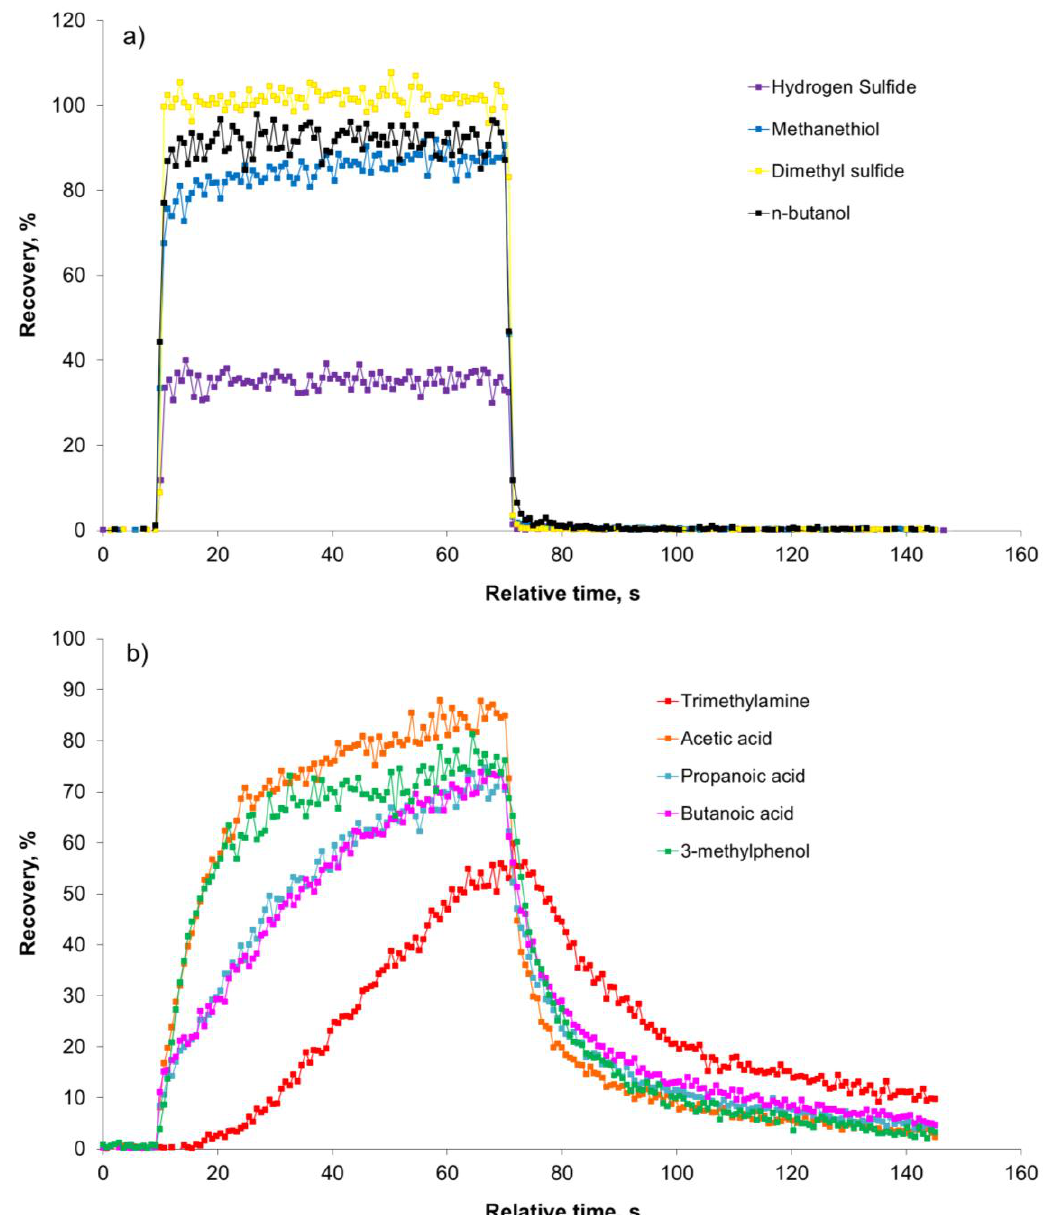
Figure 3. Development in the recovery during a 60-second pulse for selected odorants in an olfactometer. The odorants were introduced to the olfactometer after 10 s and the pulse stopped after 70